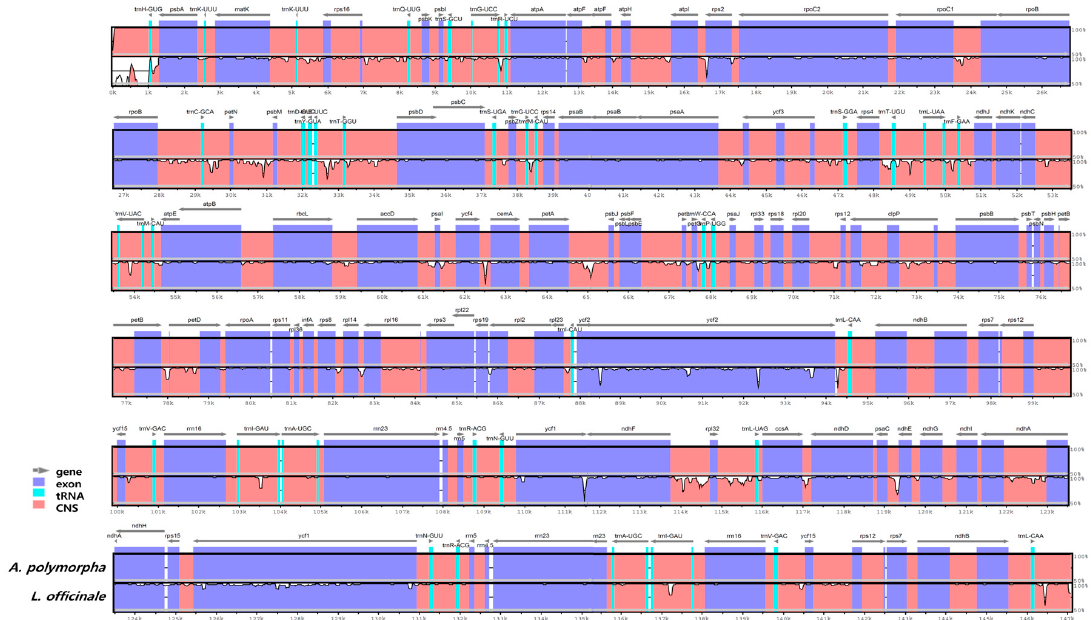
Figure 3. Comparative analysis of the CP genomes of A. polymorpha and L. officinale using mVISTA. Complete CP genomes of the two species were compared, with the CP genome of A. polymorpha used as a reference. Blue block, conserved genes; sky-blue block, tRNA and rRNA genes; red block, conserved non-coding sequences (CNSs); white block, regions polymorphic between A. polymorpha and L. officinale .